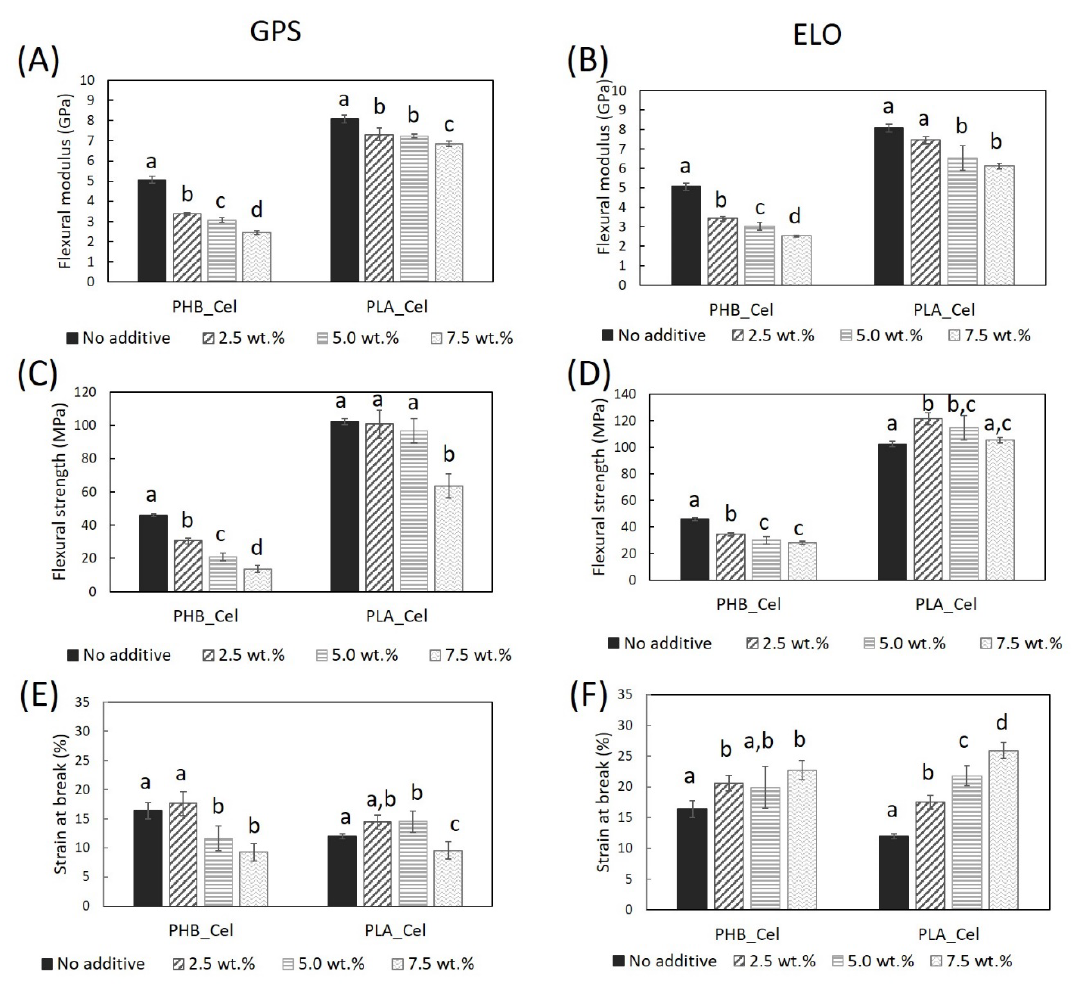
Figure 4. Flexural mechanical properties of the PHB- and PLA-based composites without additives and with GPS ( A , C , E ) and ELO ( B , D , F ) additives. Different letters (a,b,c,d) indicate statistically significant differences ( p < 0.05).